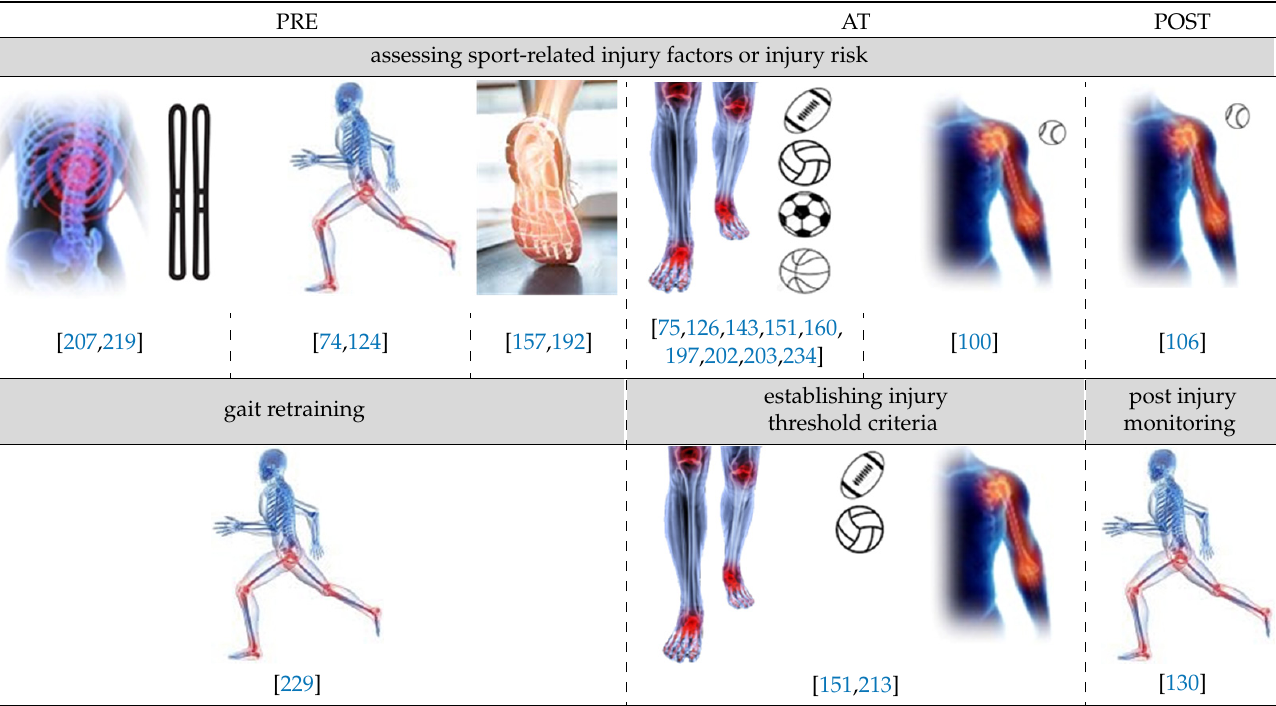
Table 3. Studies at the deployment level (IrRL3), divided by time setting and scope. Icons represent the body region related to the injury and the sport involved. PRE AT POST assessing sport-related injury factors or injury risk